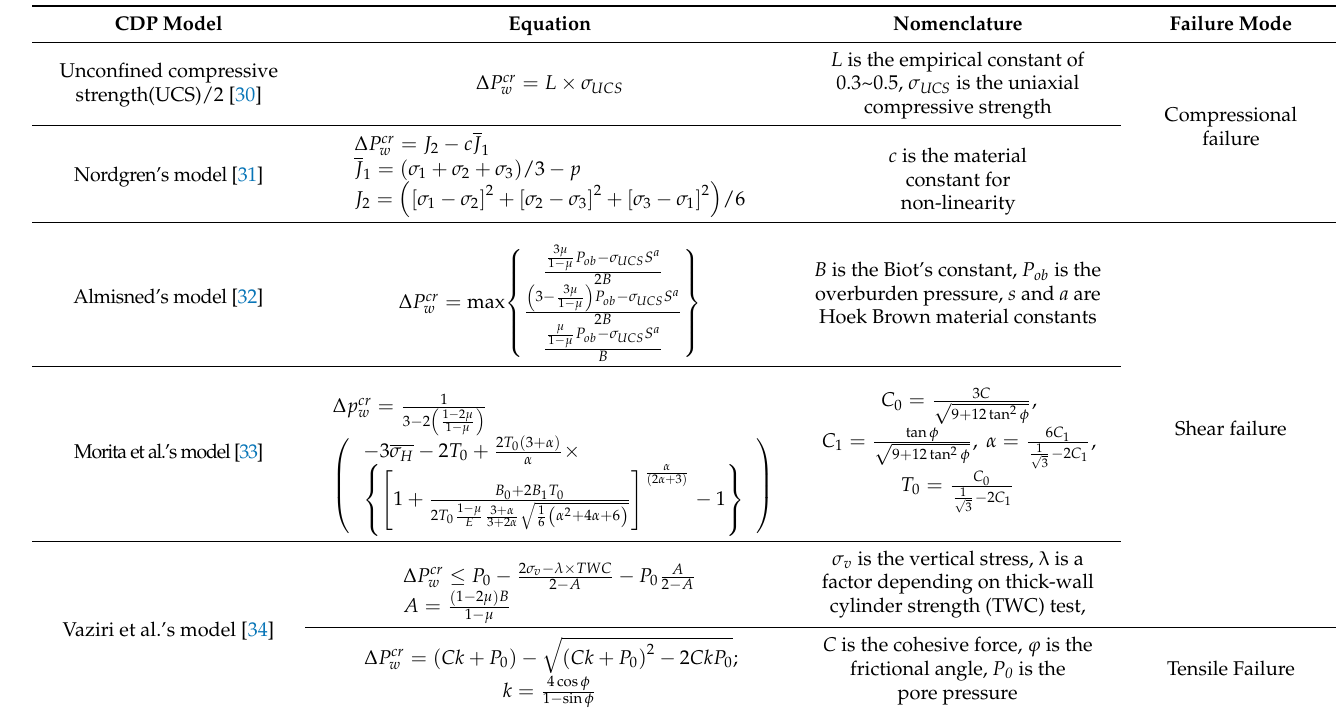
Table 2. Analytical equation of CDP for sanding production in the